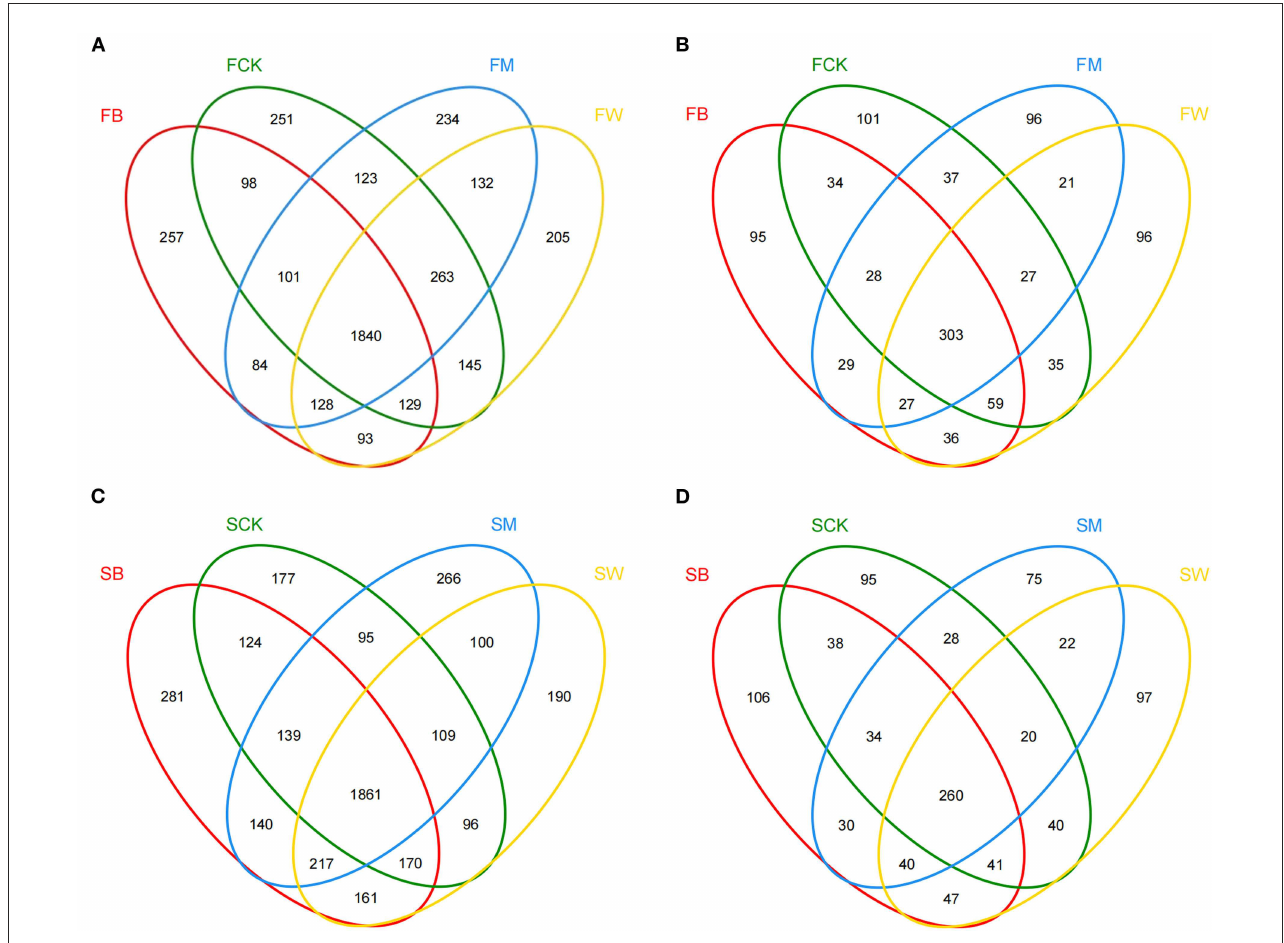
FIGURE2 Venn diagrams of OTU distribution of the 16S rRNA gene (A, C) and the ITS gene (B, D) among the eight treatments in two